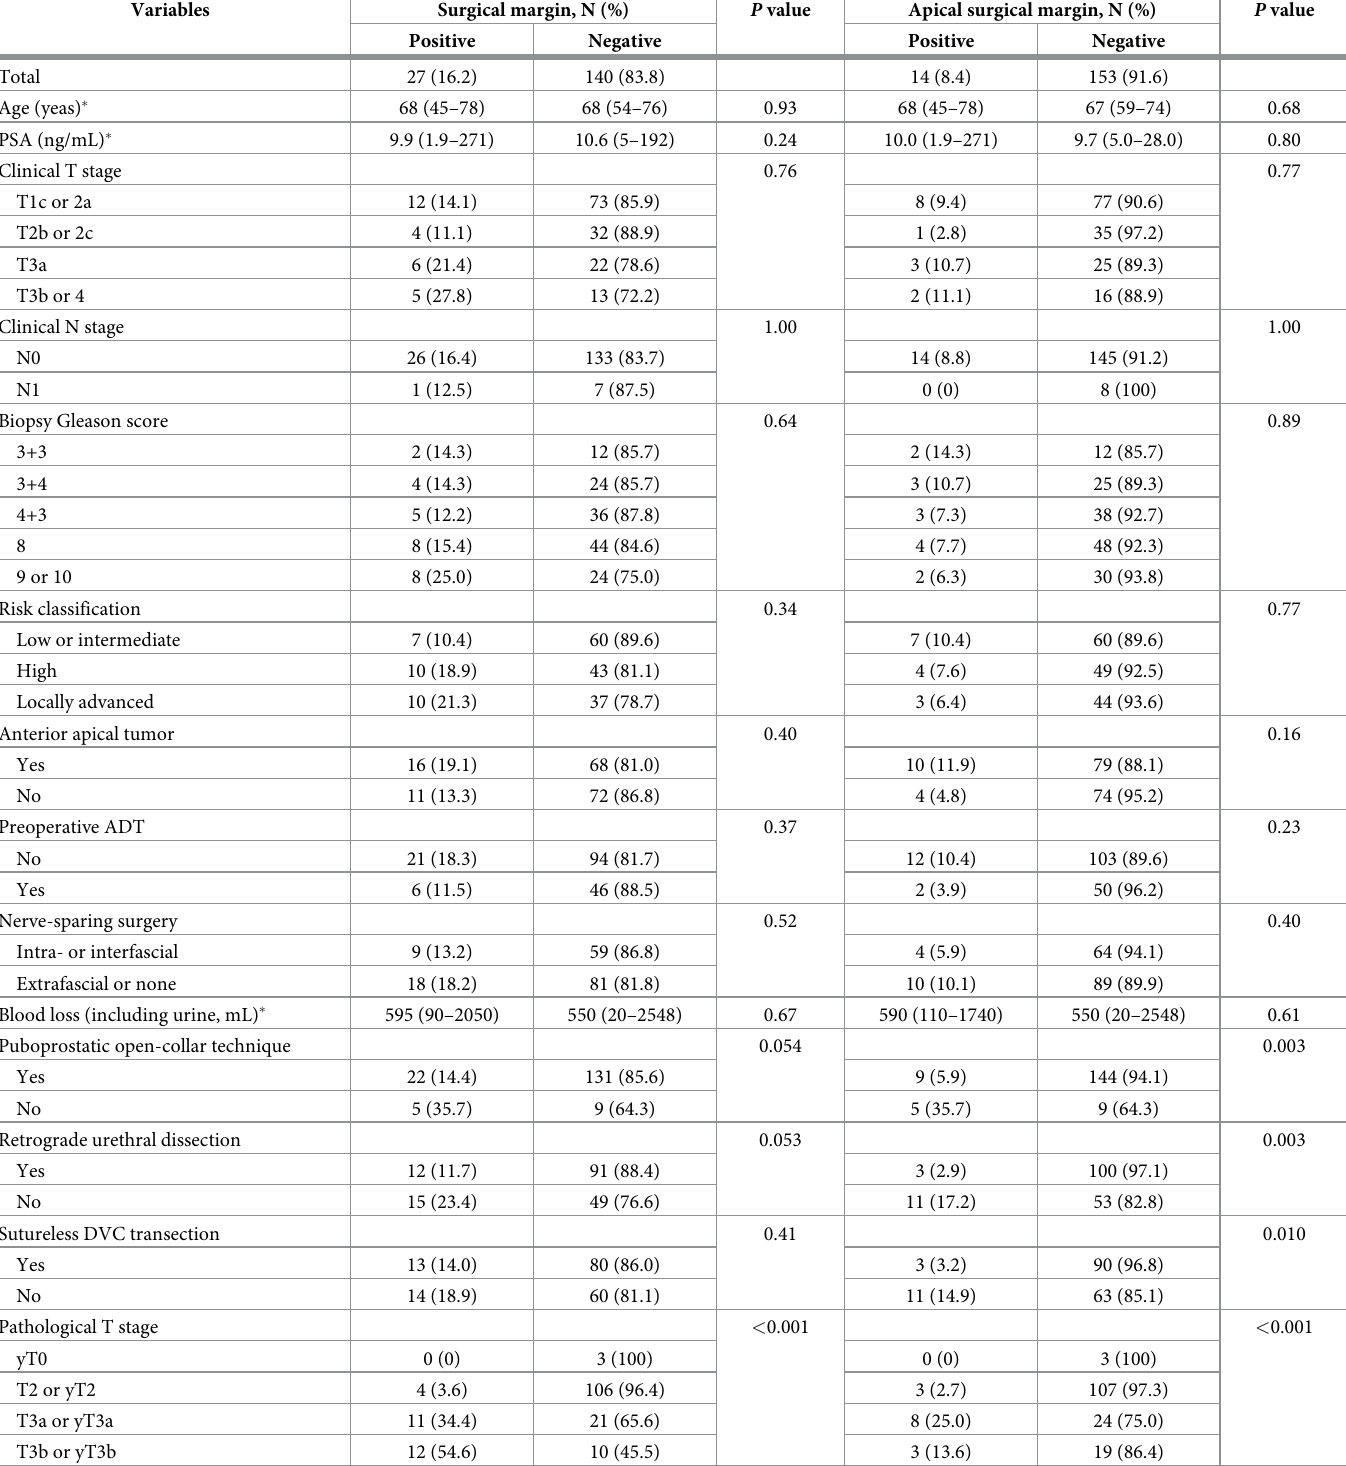
Table 2. Associations of clinicopathologic variables with surgical margin